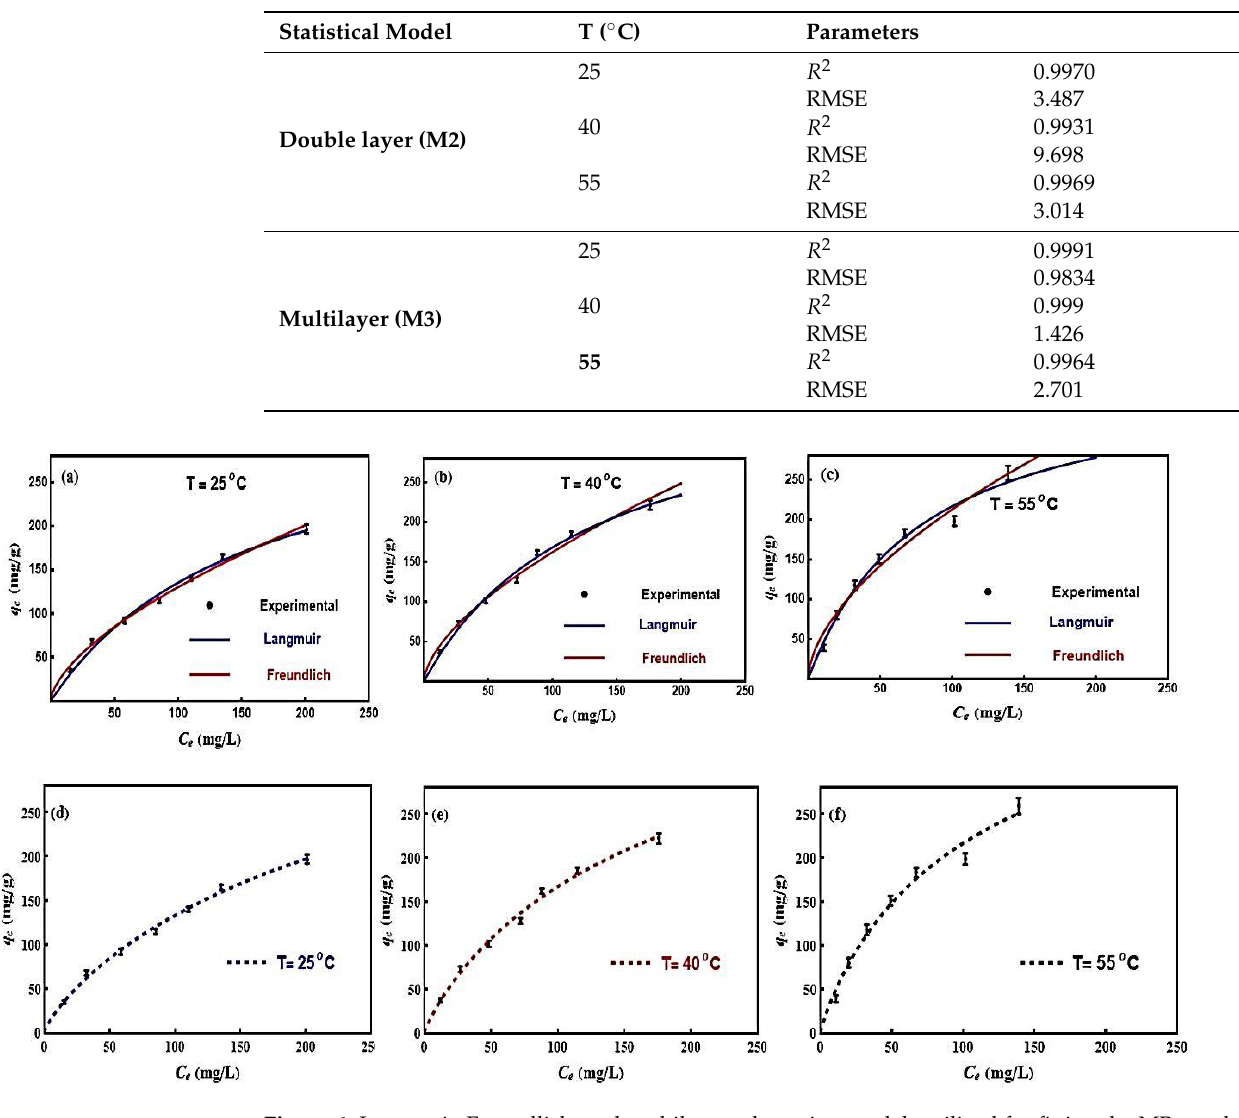
Figure 6. Langmuir, Freundlich, and multilayer adsorption models utilized for fitting the MB uptake by the BE/SD – MNPs composite. Classical models ( a – c ) and advanced monolayer model ( d – f ) at different